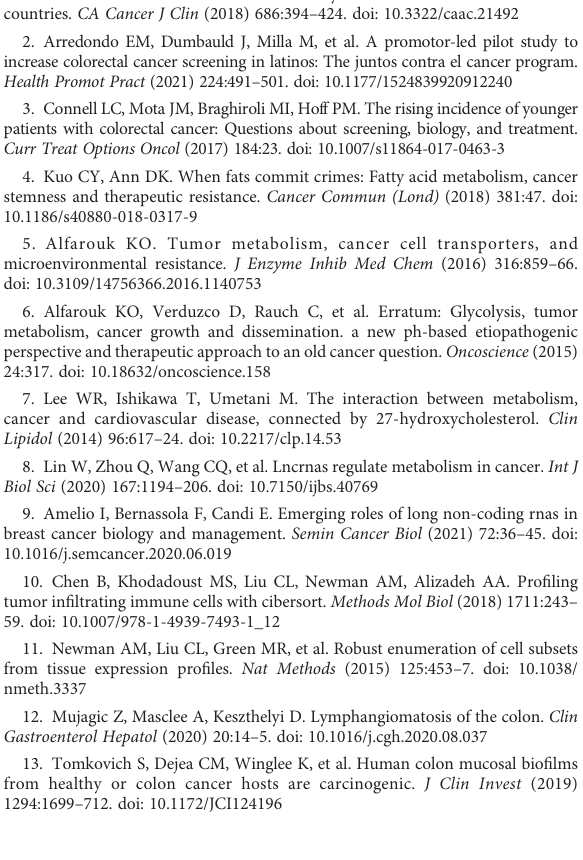
SUPPLEMENTARY TABLE 3 According to Pearson correlation analysis, 226 metabolic-related lncRNAs were obtained, and the standards were set as |R2|>0.5 and p<0.05. SUPPLEMENTARY TABLE 4 Multi-factor COX regression analysis was used to construct a prognostic risk prediction model based on the 13 metabolic-related lncRNAs. SUPPLEMENTARY TABLE 5 Detailed sequences of primers used in qRT-PCR